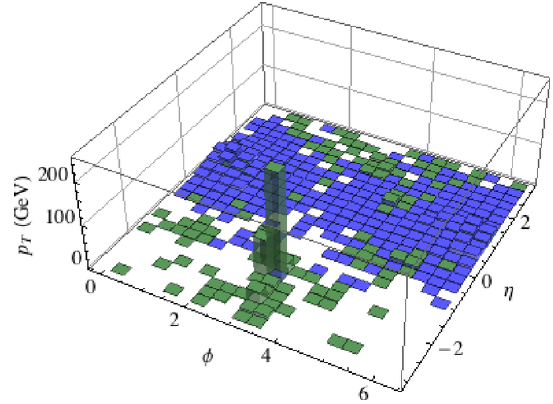
Figure 4. Truth-level lego plot of an example event for the m S = 750 GeV benchmark. The distribution of leptons (blue) and other particles (green) are indicated separately as function of the azimuthal angle and the pseudo-rapidity. This event contains a relatively hard ISR jet recoiling against the much more di(cid:11)use soft